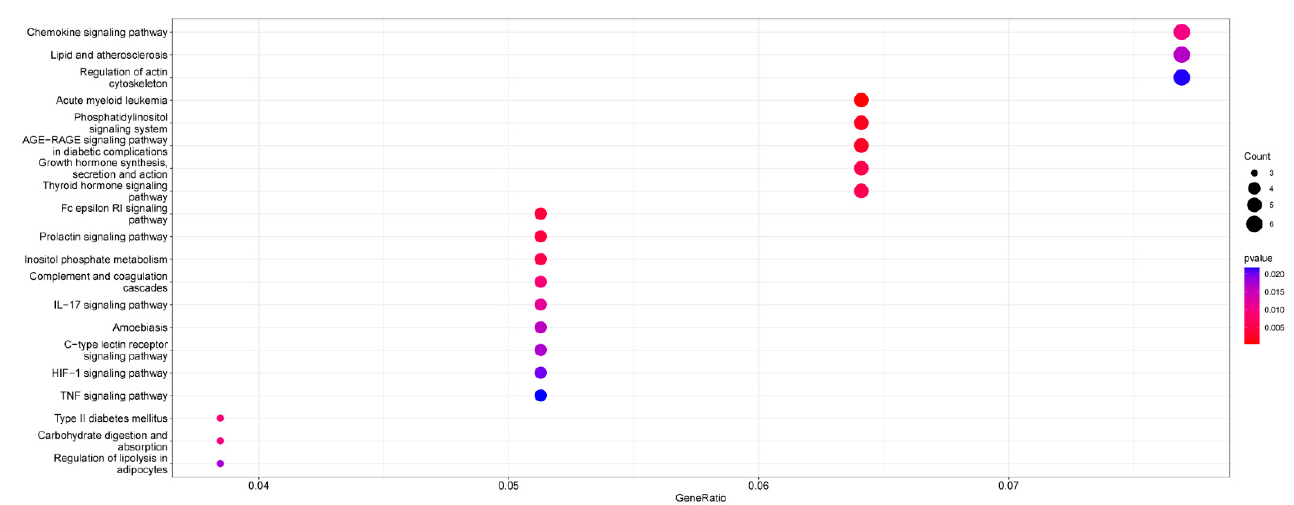
Figure 3. KEGG pathway enrichment analysis of RRA-analysed di ff erential genes.